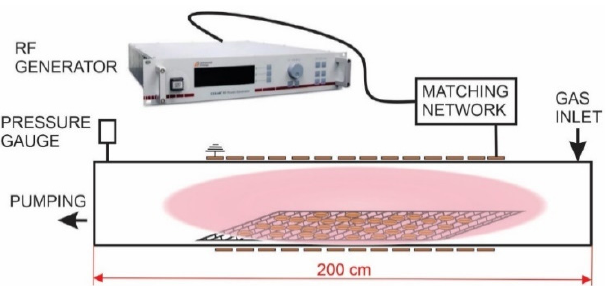
Figure 6. Schematic representation of industrial plasma reactor used to treat wheat seeds. Inductively coupled plasma was generated inside a 14-turn excitation coil